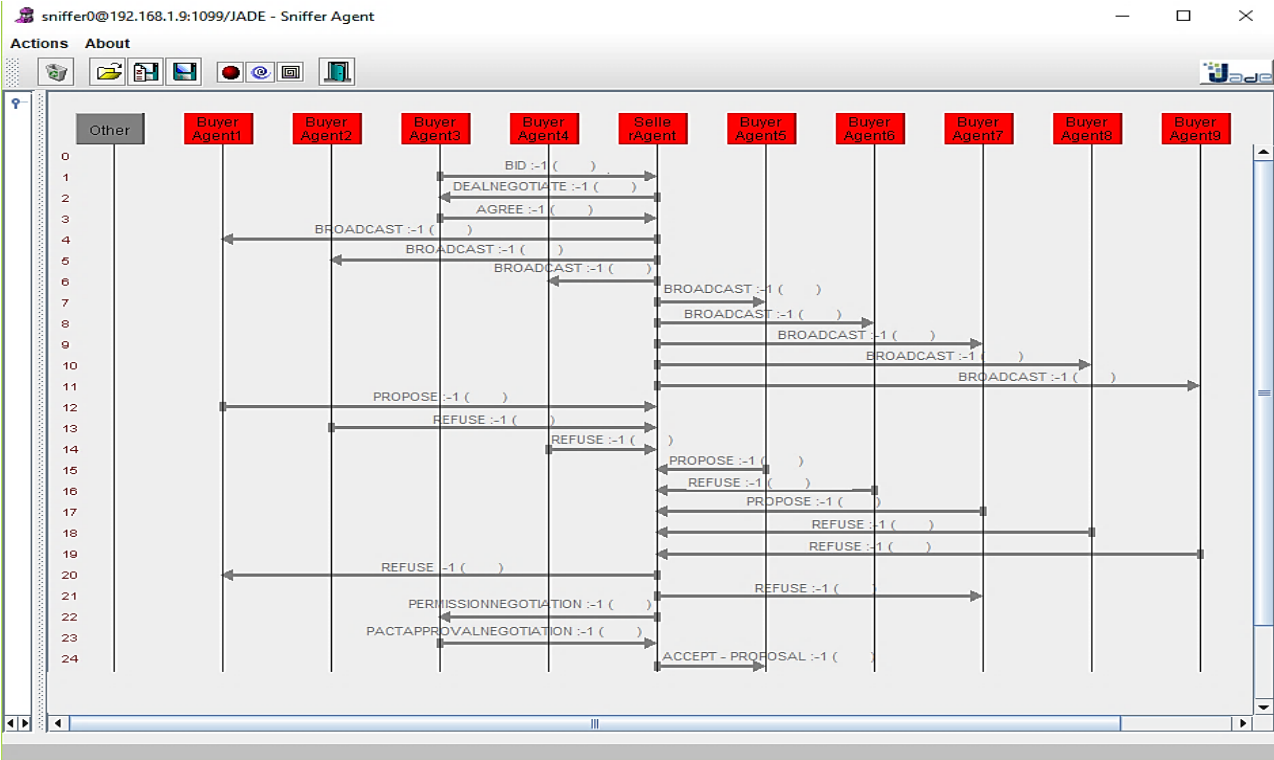
Fig. 1. Bidding a mobile of buyer agent by using e-commerce performative in